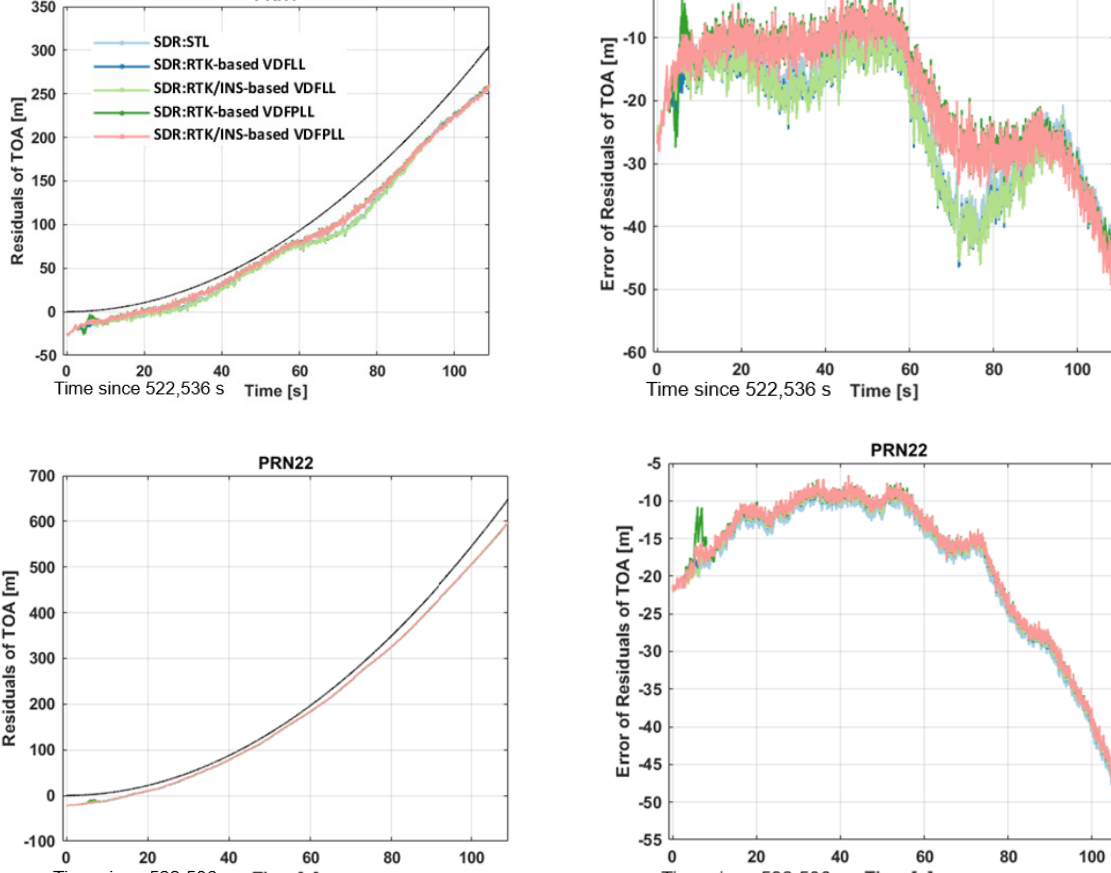
Figure 10. Error curves of the TOA residuals for the GPS satellites PRN1 and PRN22 in the open-sky